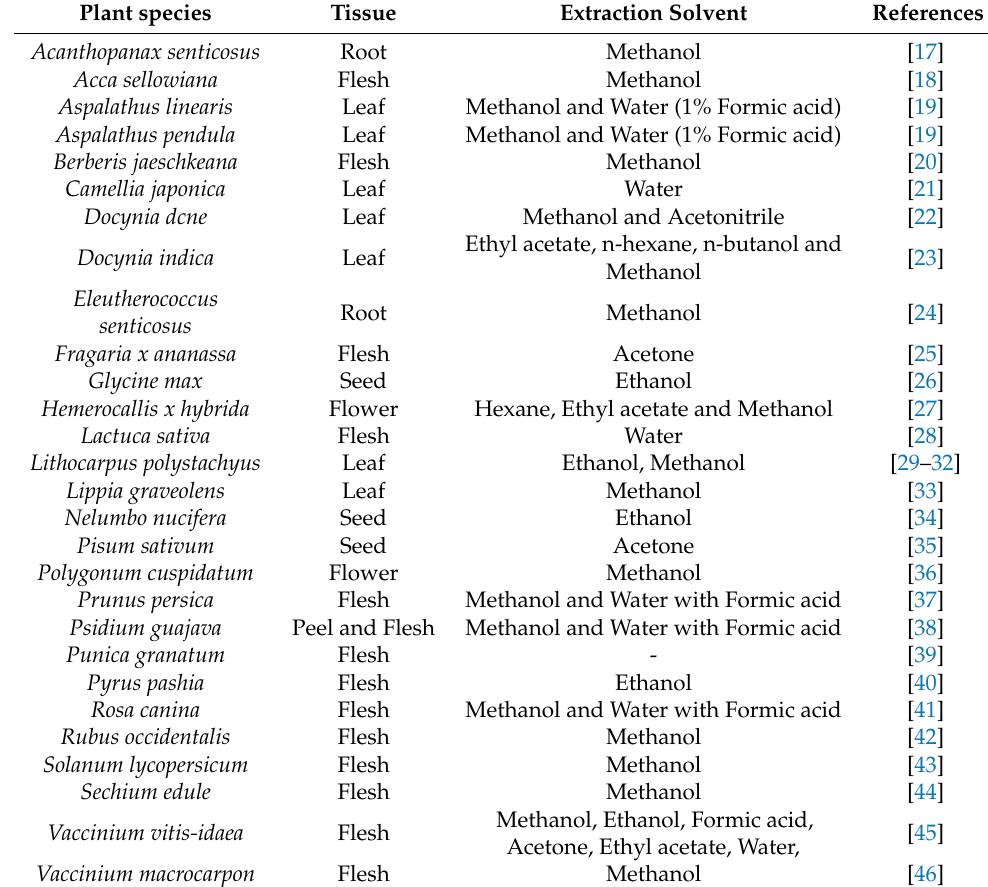
Table 1. Phloridzin-containing plant